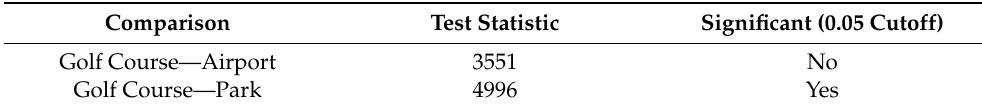
Table 3. The Wilcoxon test statistic and p -value interpretation for the landcover percentage burned comparisons.